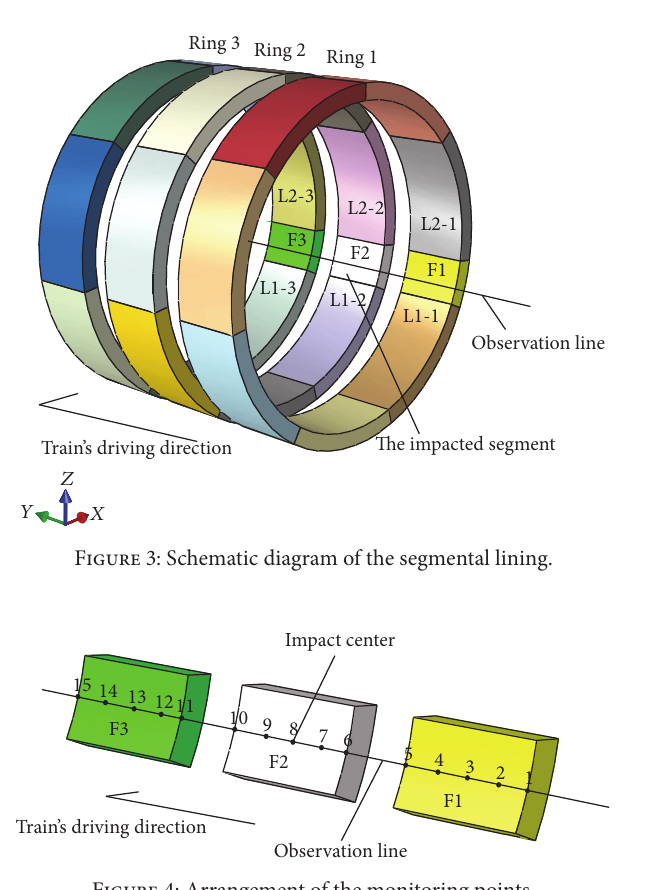
the relative translation and rotation between the two bolt ends in any direction. Regarding the interaction between the adjacent segments, interface elements with “hard contact” were employed to transmit the contact pressure between the joint surfaces of the adjacent segments. Moreover, the penalty